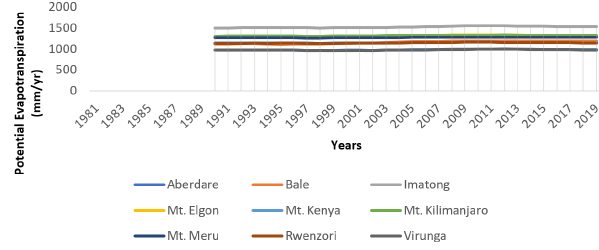
Figure A3. The 10-year moving averages of mean annual PET at the different water towers.